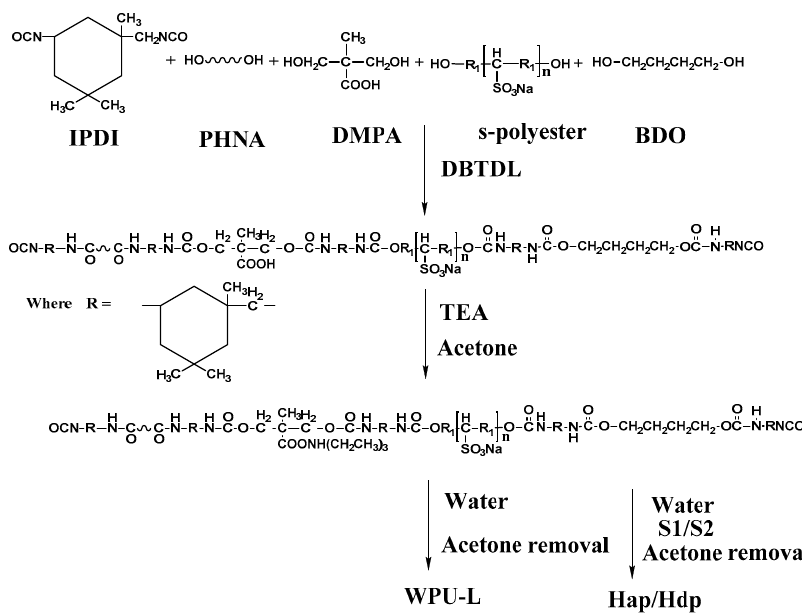
Figure 1. The scheme of the formation of WPU-L and WPU-Hap/Hdp.